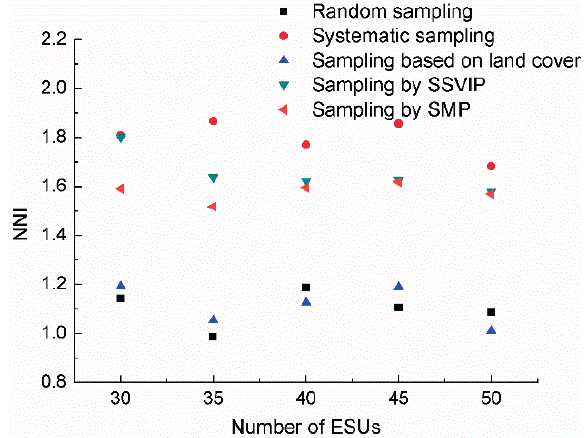
Figure 7. The NNI values for the ESU pattern using the random sampling, systematic sampling, sampling based on the land-cover map, SSVIP and SMP with different numbers of